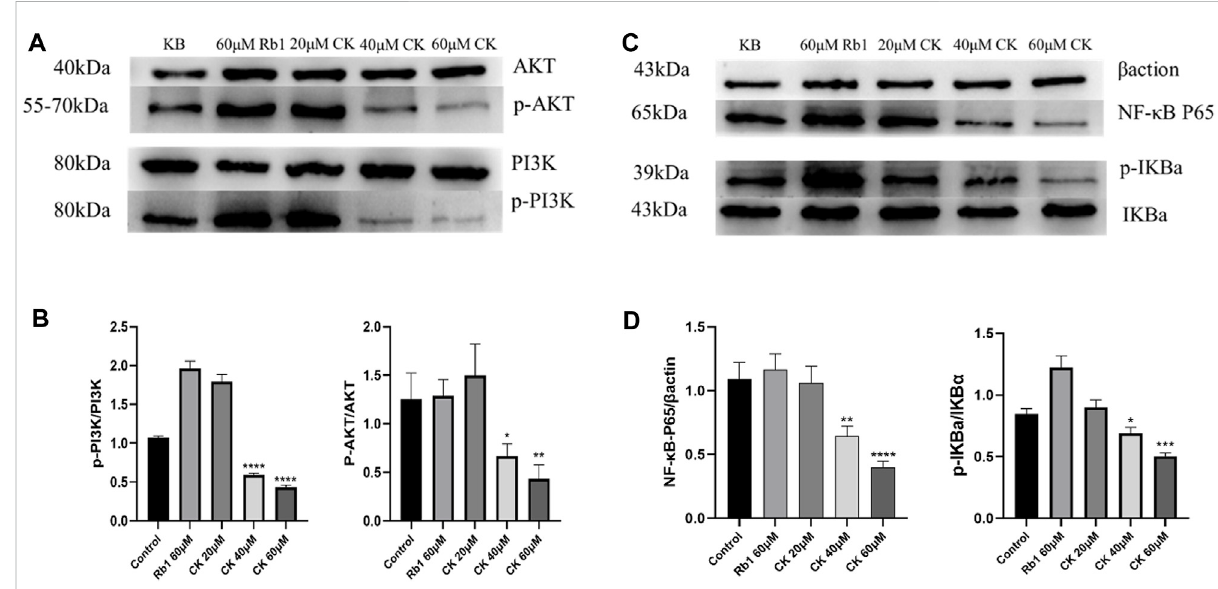
FIGURE 6 Effects of Ginsenoside Rb1 and Ginsenoside CK on Apoptosis-related Pathways Proteins in HGC-27 (A) Apoptosis-related pathways PI3K, p-PI3K, AKT, p-AKT bands. (B) Histogram comparing the expression of p-PI3K and p-AKT proteins in apoptosis-related pathways. (C)